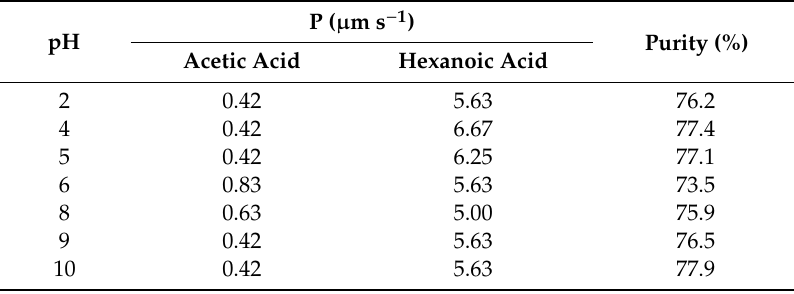
Table 1. Permeability coefficient (P) and purity at different pH values. pH